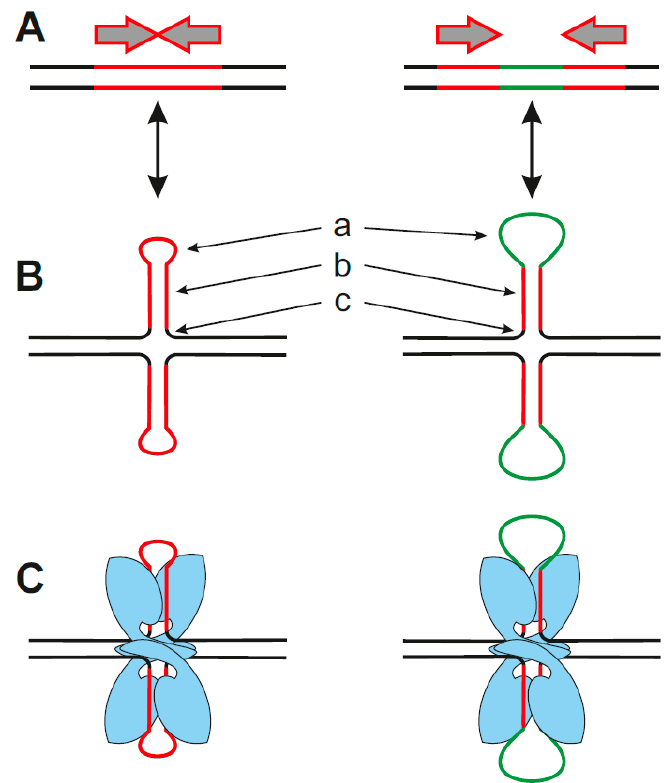
Figure 4. Cruciform structure formation ( A ) inverted repeat (red) without spacer (left part) or with spacer (green–right part) is required for ( B ) cruciform structure formation, the length of the repeat and spacer influence the length of the single-stranded loop (a), size of the stem (b). Every cruciform consist of four-way junction (c). Two p53 half-sites formed by inverted repeats could be close in cruciform structure allowing effective binding of p53 (blue) ( C ).